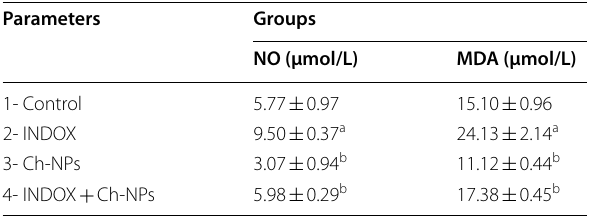
Table 3 The effect of Ch-NPs on the NO and MDA serum levels in rats